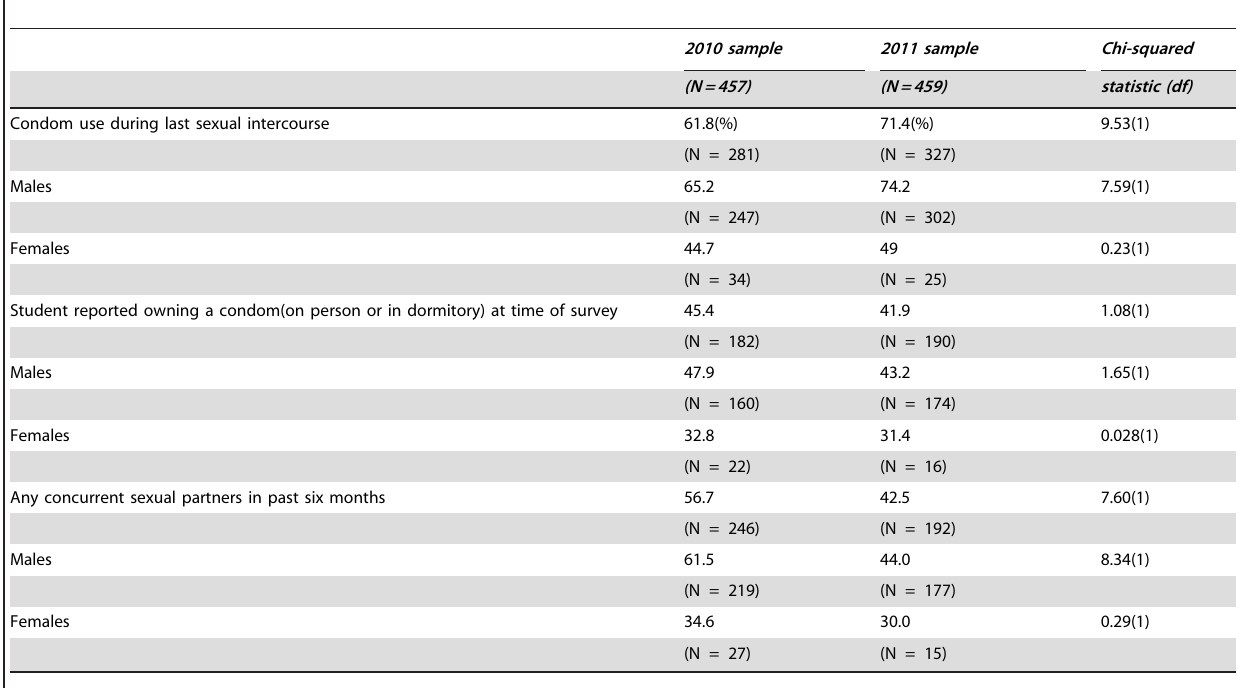
Table 2. Comparisons of 2010 and 2011 Hawassa University student sexual